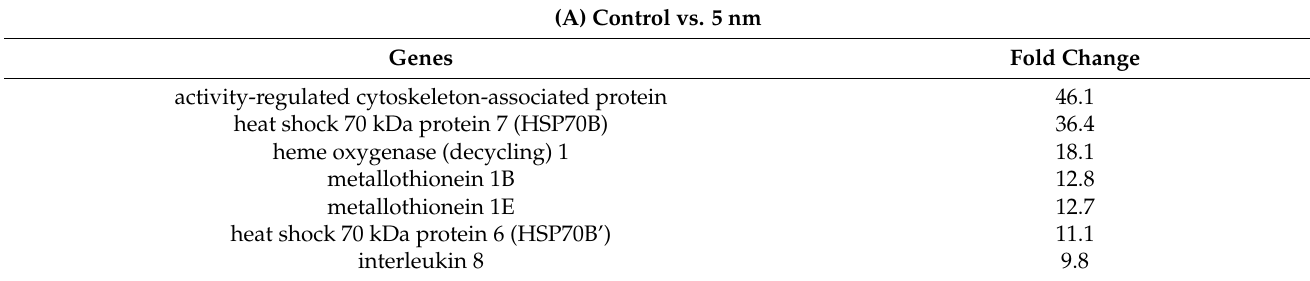
Table 3. List of increased genes after silver NP exposure in BEAS-2B